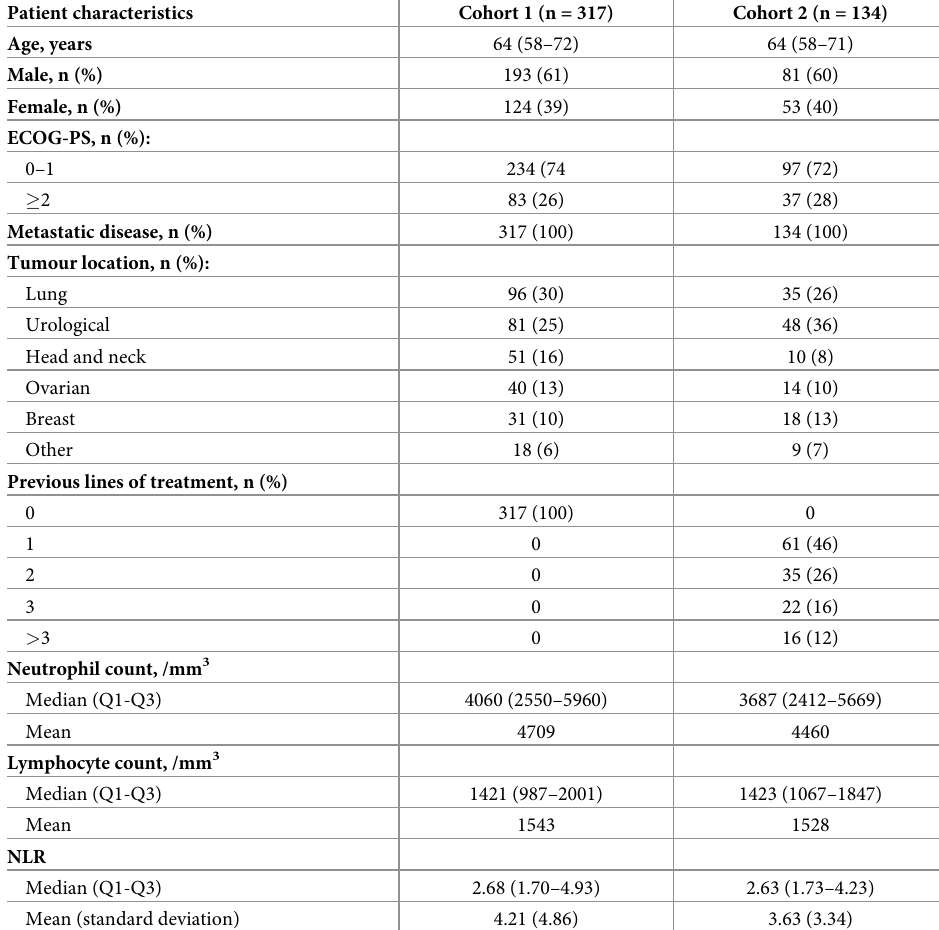
Table 1. Baseline demographics and clinical characteristics. Patient